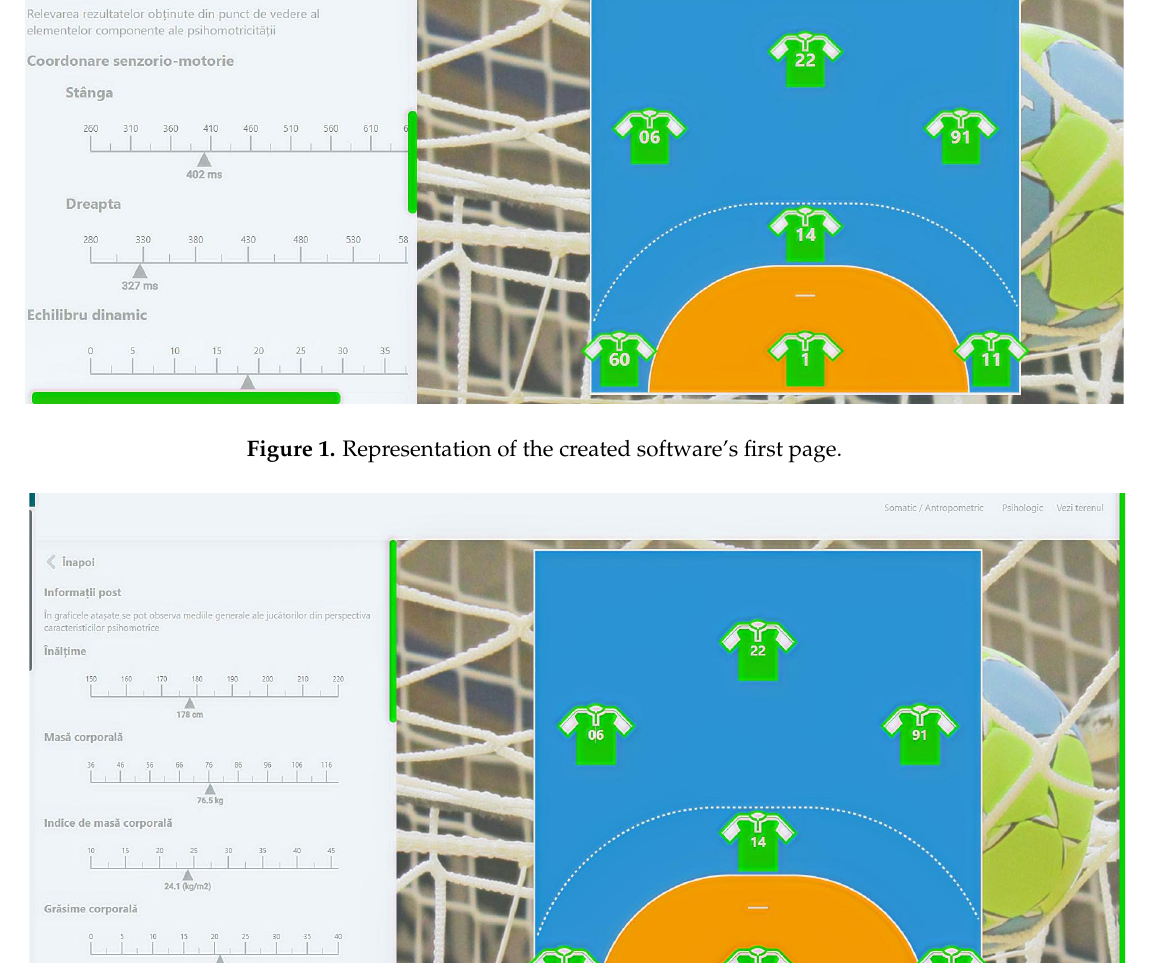
Figure 2. Representation of the software’s second page.